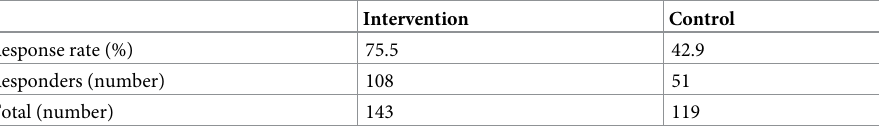
Table 2. Response rate for the intervention and control